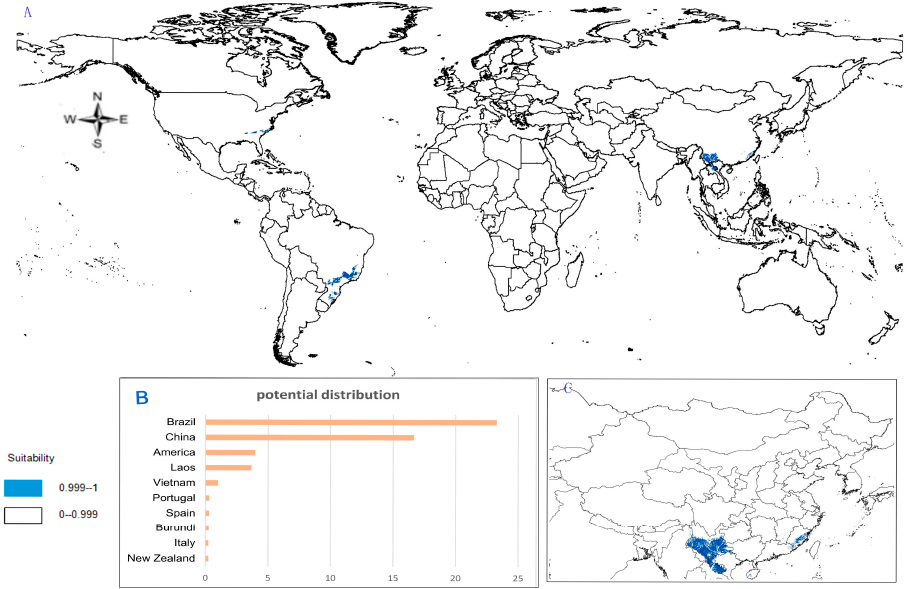
Figure 5. Spatial distribution map of potential suitable distribution for P. zingiberensis by GMPGIS .